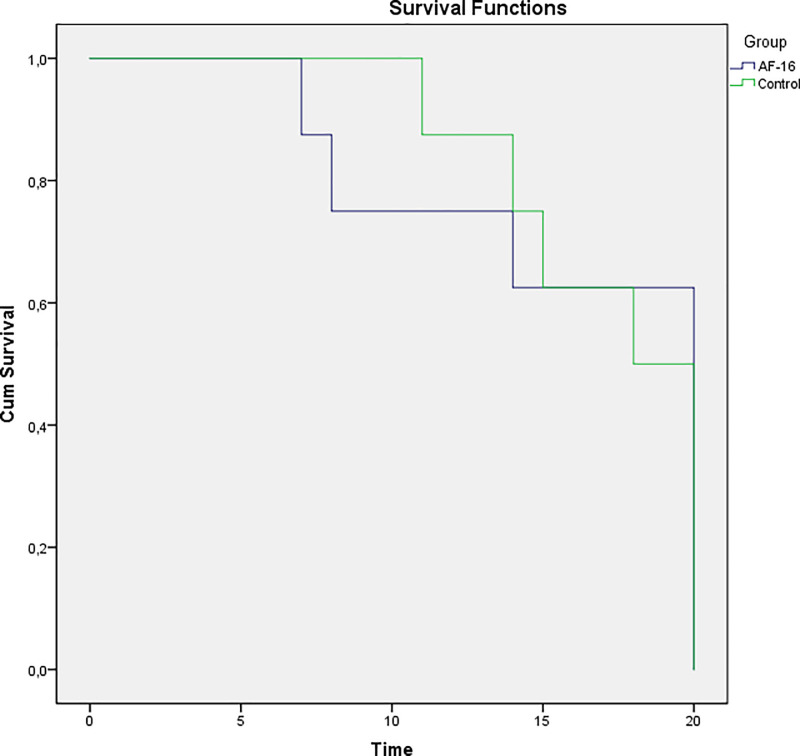
Kaplan-Meyer analysis of survival.Of a total of 8 + 8 animals, 9 survived the experiment until euthanasia (20 hours), while three and four animals died of refractory shock during the 20-hours observation period in treatment and control groups, respectively.